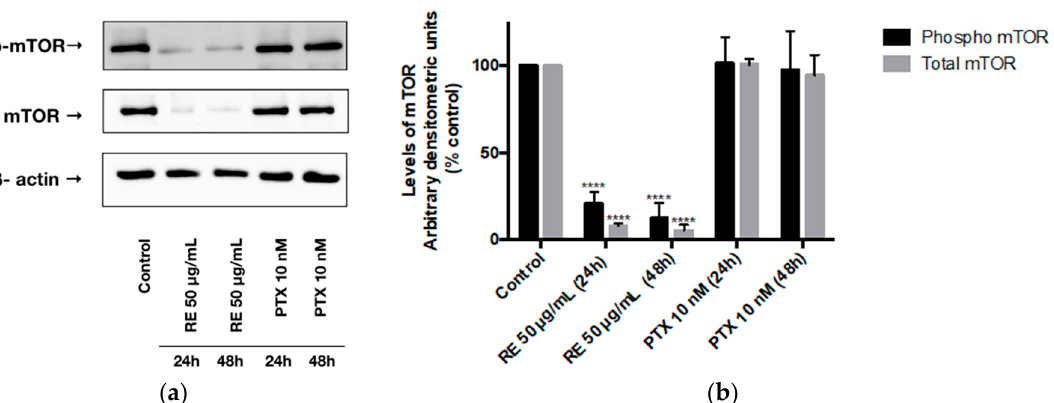
Figure 4. Effect of rosemary extract on mTOR. Cell lysates were prepared from MDA-MB-231 cells treated with either 50 µg/mL rosemary extract (RE) or 10 nM paclitaxel (PTX) for 24 or 48 h. Cell lysates (20 µg) were immunoblotted using specific antibodies against mTOR, phosphorylated/activated mTOR, or β -actin. Representative immunoblots are shown ( A ). The densitometry of the bands, expressed in arbitrary densitometric units, was corrected to β -actin levels and is presented as percent of control ( B ). The data are the mean ± SEM of three independent experiments. **** p < 0.0001.